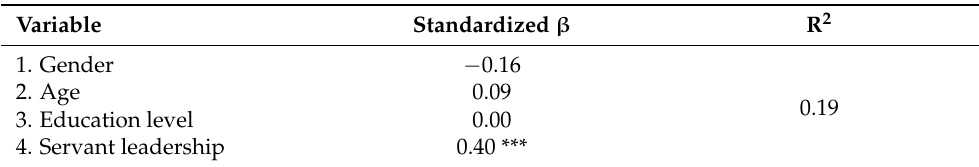
Table 2. Linear regression